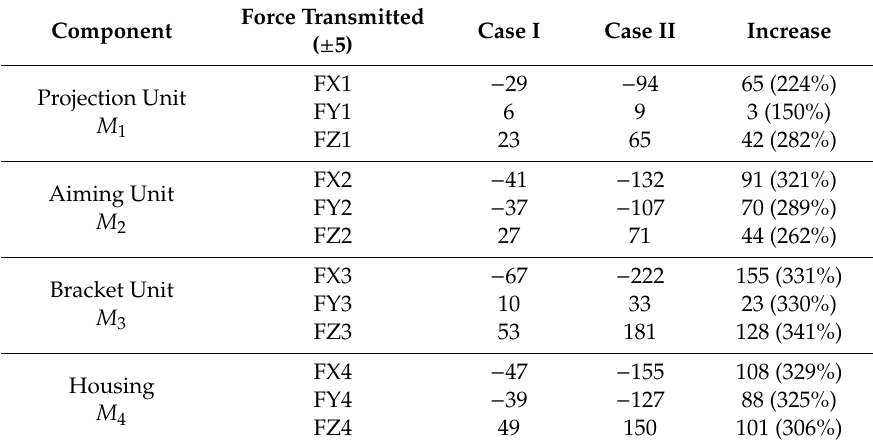
Table 2. Comparison of force transmission results from GUI for case I and case II.